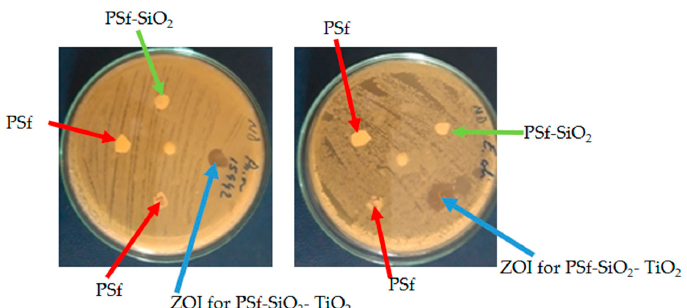
Figure 10. Petri-dish samples showing the presence and absence of ZOI for polysulfone (PSf) composite membranes.